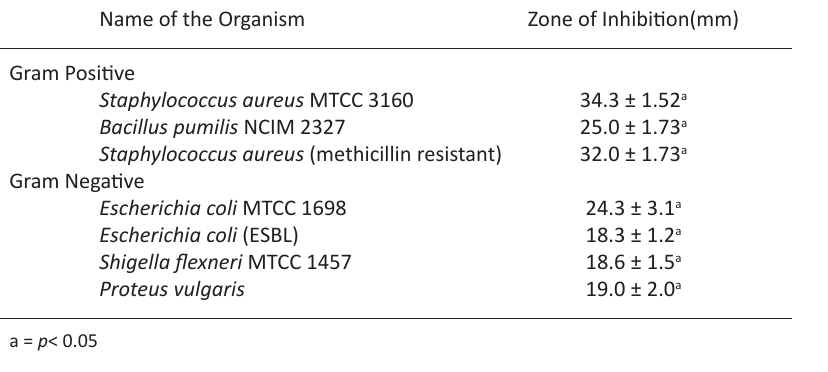
Table 6. Antimicrobial activity of ethyl acetate crude of SKCMM1 against reference bacterial strains.